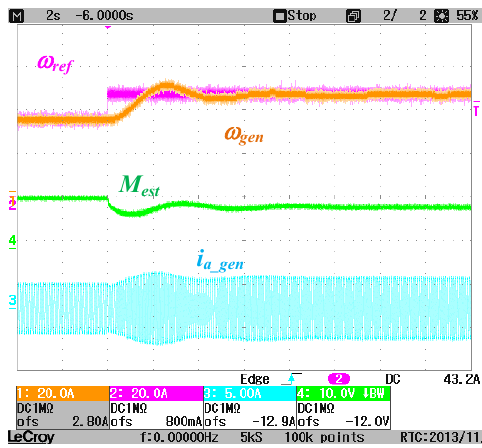
Fig. 12. Response for step change of speed. From top: reference speed ( ω ref ), measured speed ( ω gen ), estimated torque ( M est ), phase current (i a_gen ).